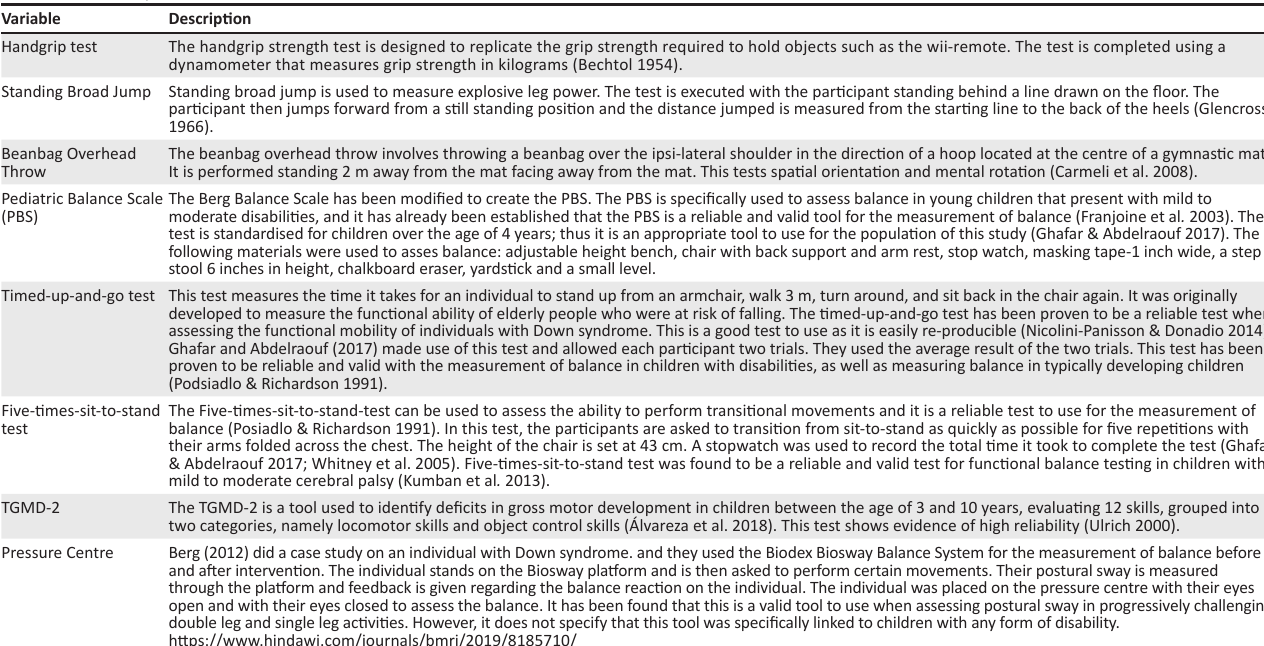
TABLE 1-A4: Description of outcome